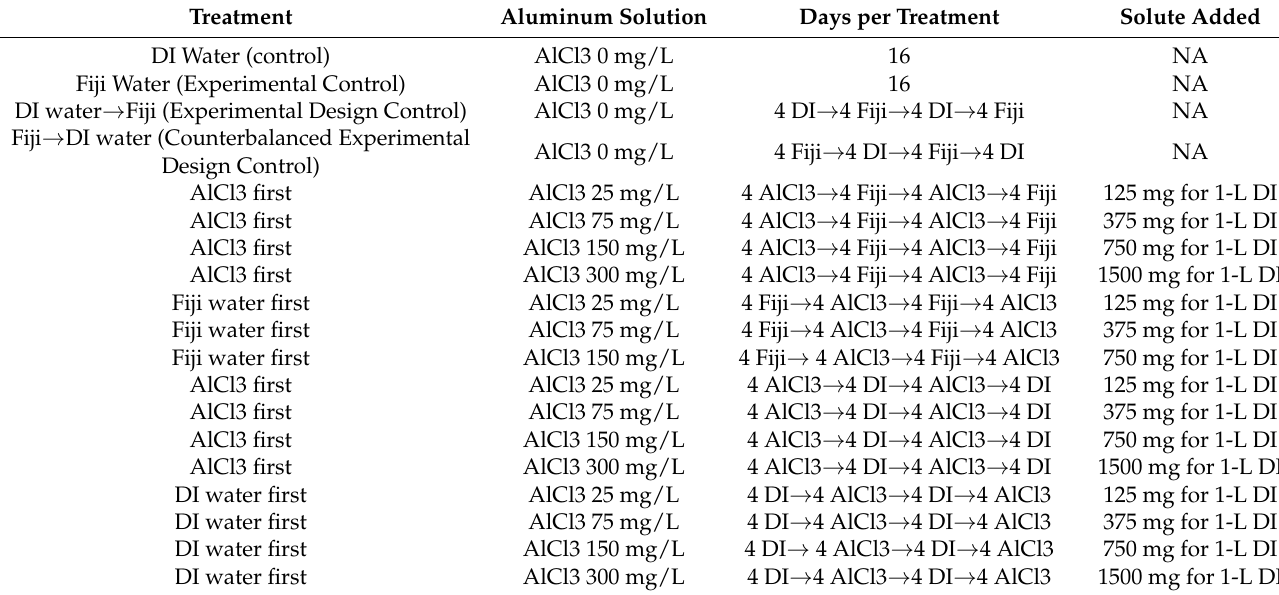
Table 1. Bee Exposure Groups and